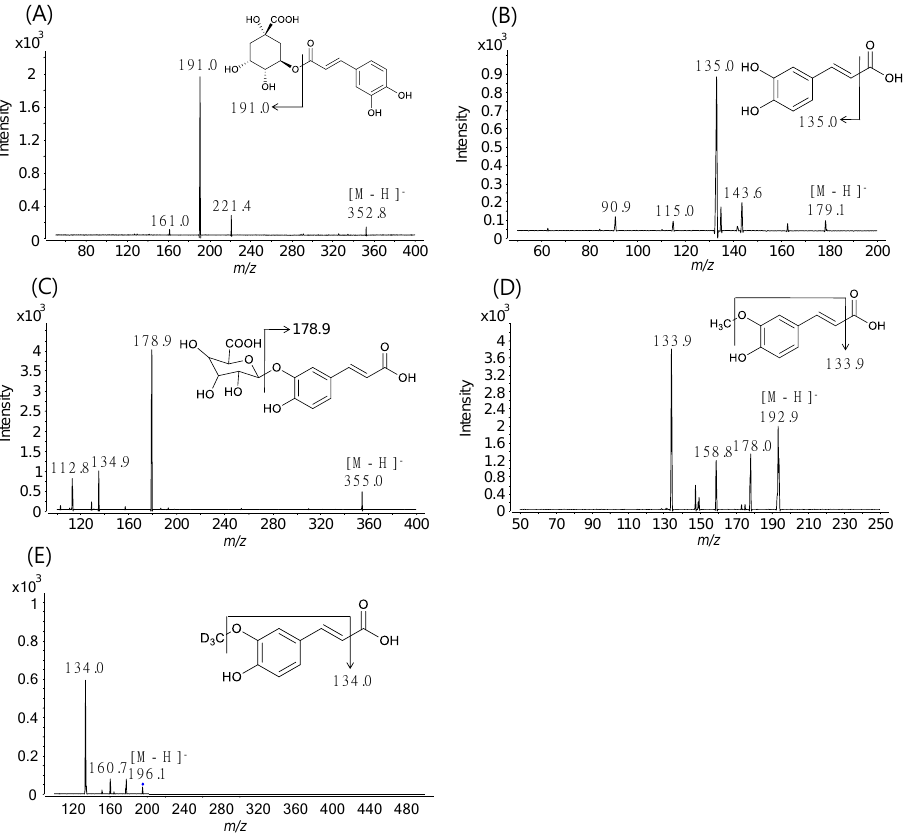
Figure 2. Product ion spectra of ( A ) chlorogenic acid (CGA), ( B ) caffeic acid (CA), ( C ) CA-3-G, ( D ) ferulic acid (FA), and ( E ) FA-d 3 (IS).